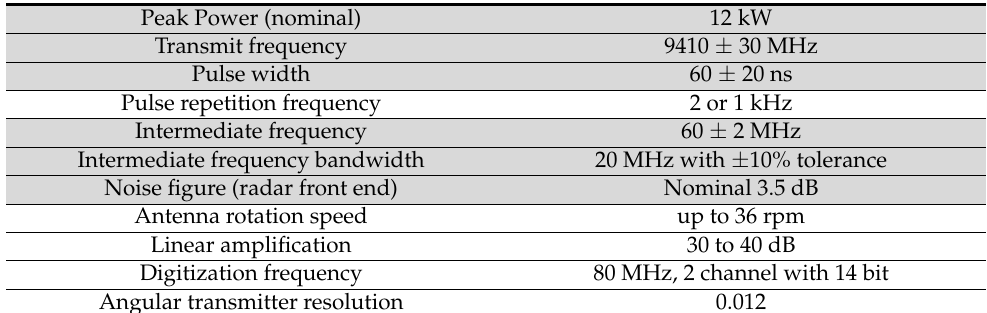
Figure 1. Coastal setup of the coherent on receive marine radar (MR) system on the Island of Sylt in the German Bight of the southern North Sea. Table 1. Main parameters of the coherent on receive radar scanner. All components used from the original scanner unit are marked in grey